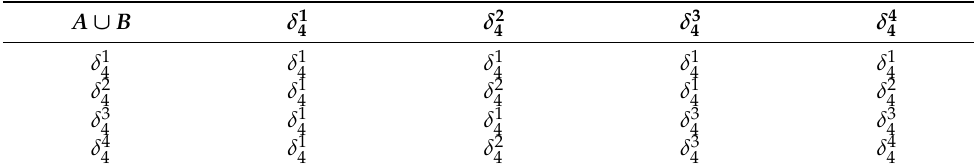
Table 2. Union in vector form.